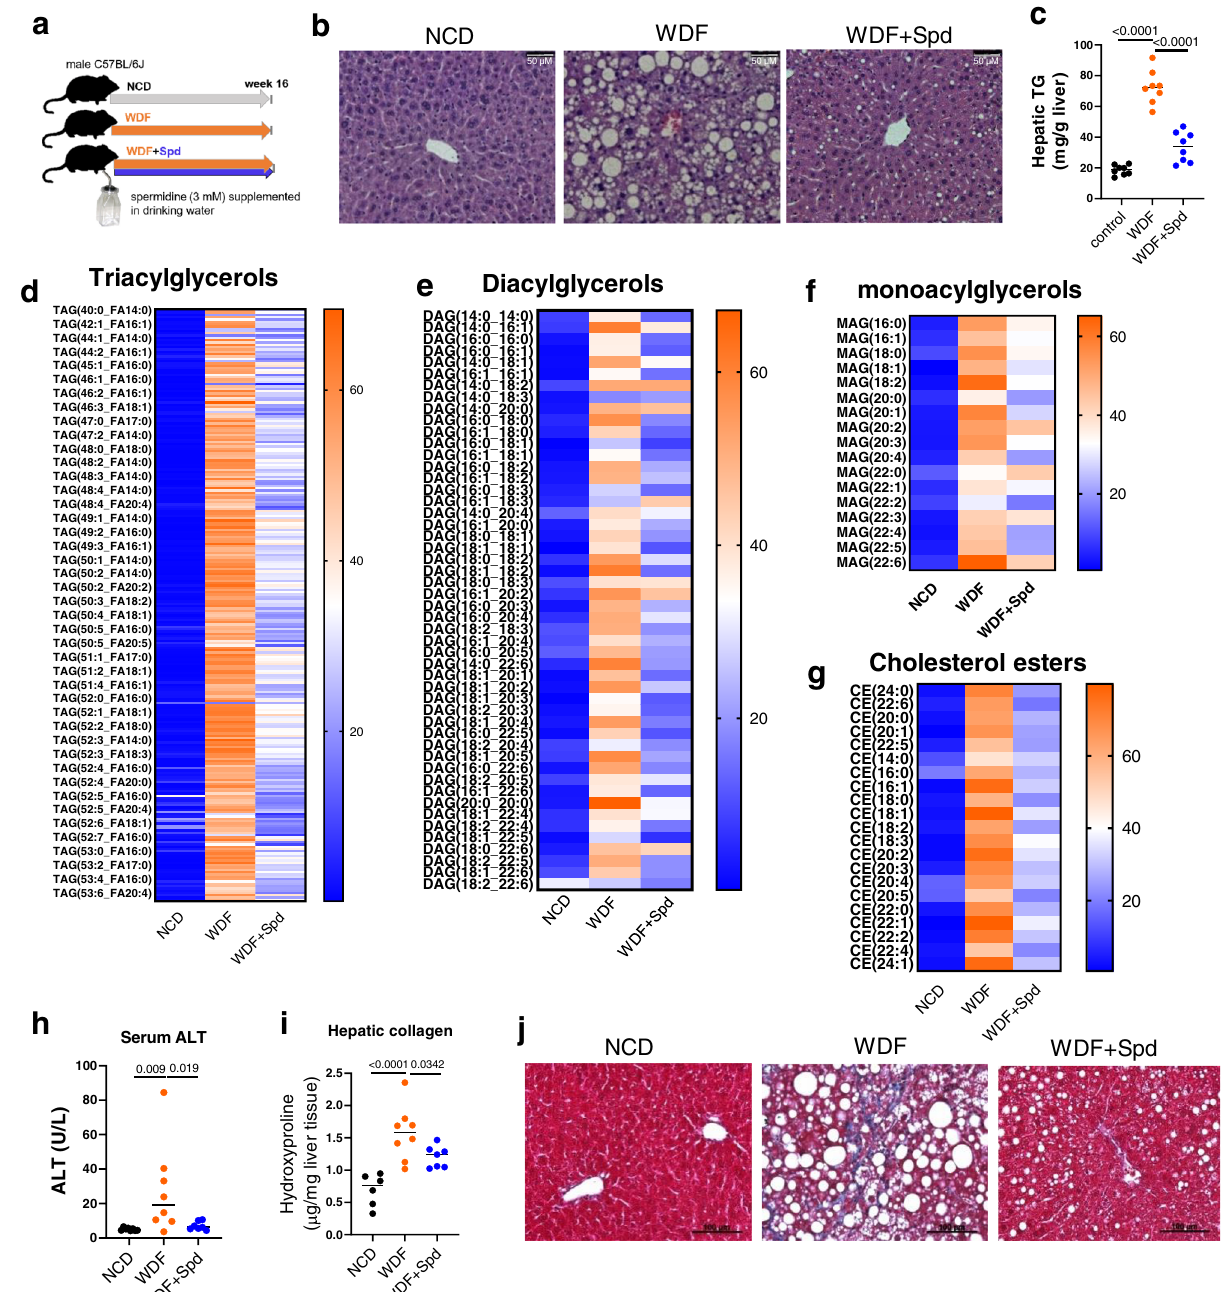
Fig.5|SpermidinesupplementationpreventedNAFLDprogressioninadietary mouse model of NASH. a Schematic showing administration protocol for sper- midine (3mM in drinking water) in mice fed with WDF for 16 weeks. b Representative images of H&E staining of the liver. ( n =5). c Hepatic triglyceride content was measured by biochemical assay. ( n =8). d – g Liquid chromatography coupled with mass spectrometry (LC-MS) lipidomic pro fi ling of hepatic triacylgly- cerols (TAGs) ( d ), diacylclycerols (DAGs) ( e ), monoacylglycerol (MAGs) ( f ), and cholesterol esters (CEs) ( g ) levels from mice fed with NCD ( n =6), WDF ( n =8), or